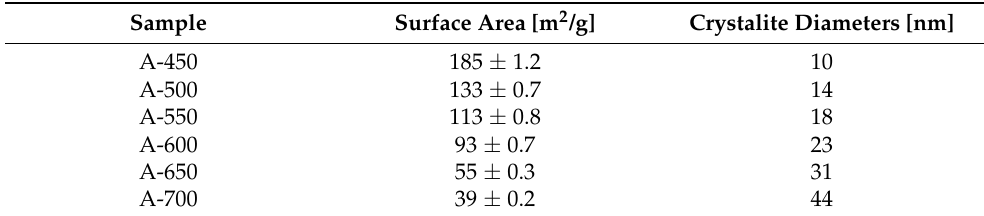
Figure 6. Photocatalytic degradation of PB with sample A calcined at different temperatures ( γ (TiO 2 ) = 0.25 g/L). Comparison of the slopes of the linear part for samples treated at 500 °C (k = 76 µg L − 1 min − 1 ) and the samples treated at 650 °C (k = 99 µg L − 1 min − 1 ) shows an increase of about 30% in photocatalytic activity. The amount of dye adsorbed on the surface decreases